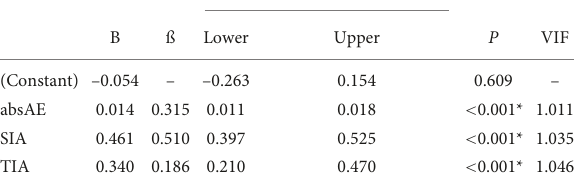
TABLE 4 Linear regression analysis of the difference vector in patients of the femtosecond group with target induced astigmatism over 0.75 D (adjusted R 2 = 0.406, p < 0.001*).